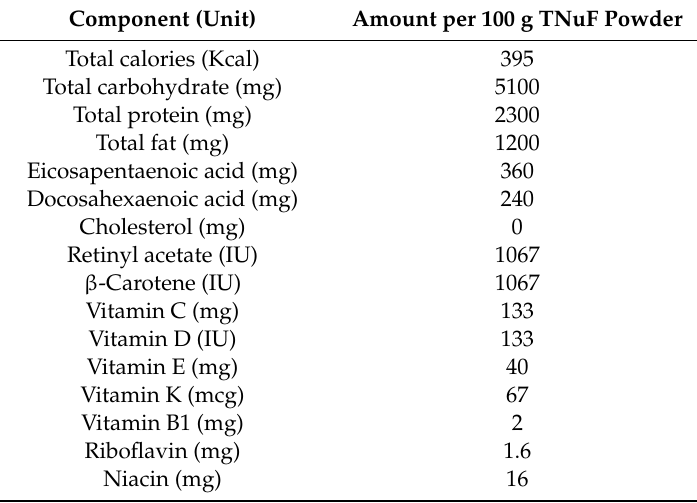
Table 2. Major components of the TNuF total nutrition